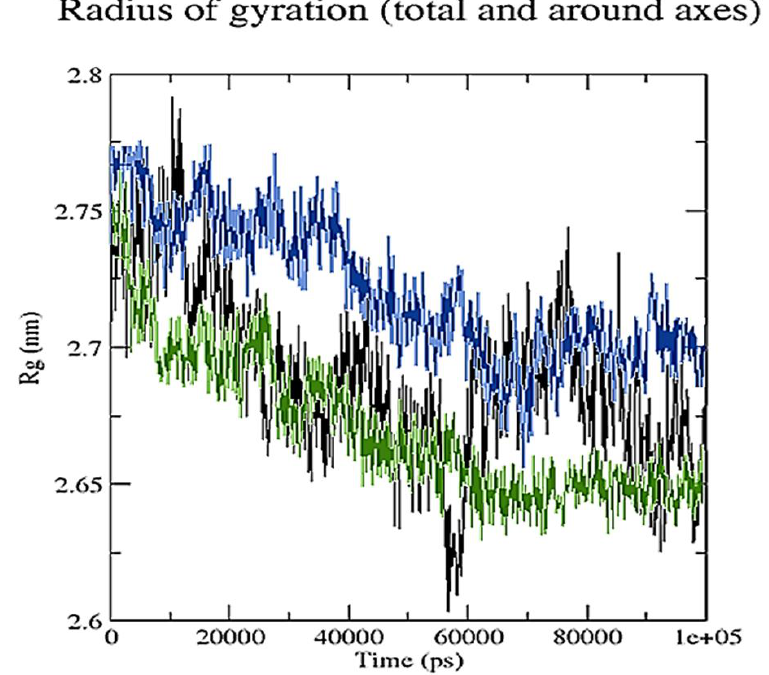
Figure 14. Radius of gyration for unbound serotonin receptor (black), RisS complex (blue), and CTcS complex (green) during the 100 ns simulation period.